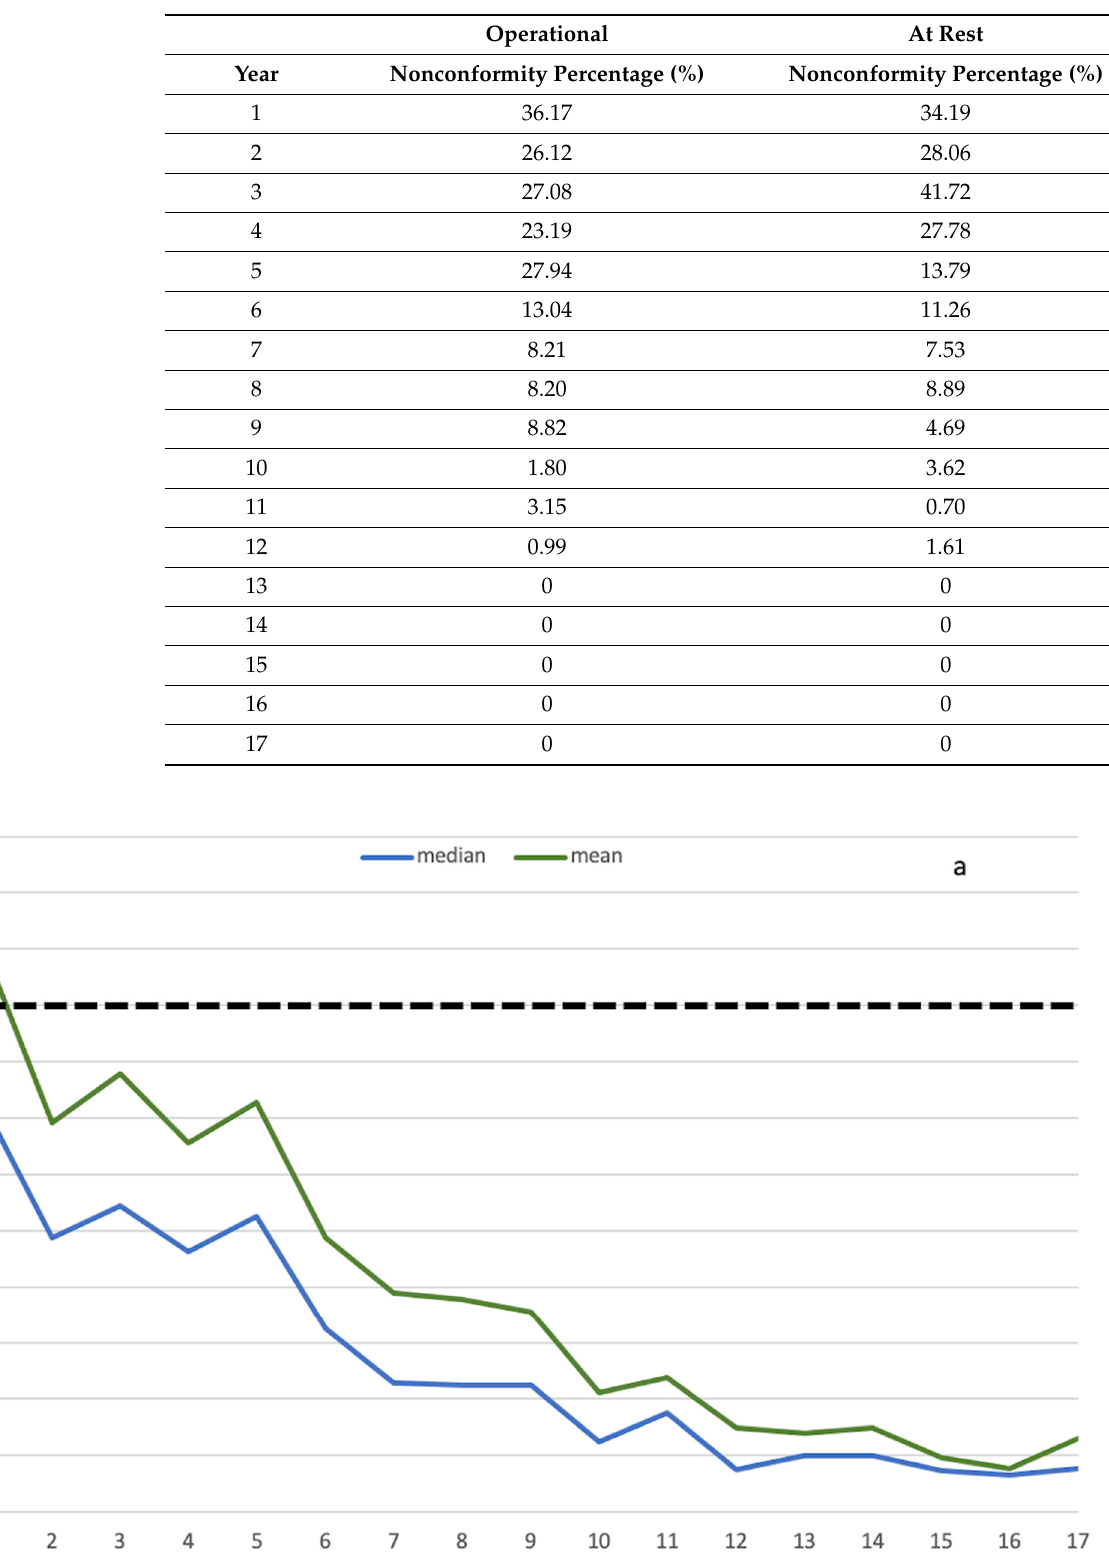
Table 1. Percentage distribution of nonconformities related to the airborne microbial concentration in operational and at rest conditions during the years of